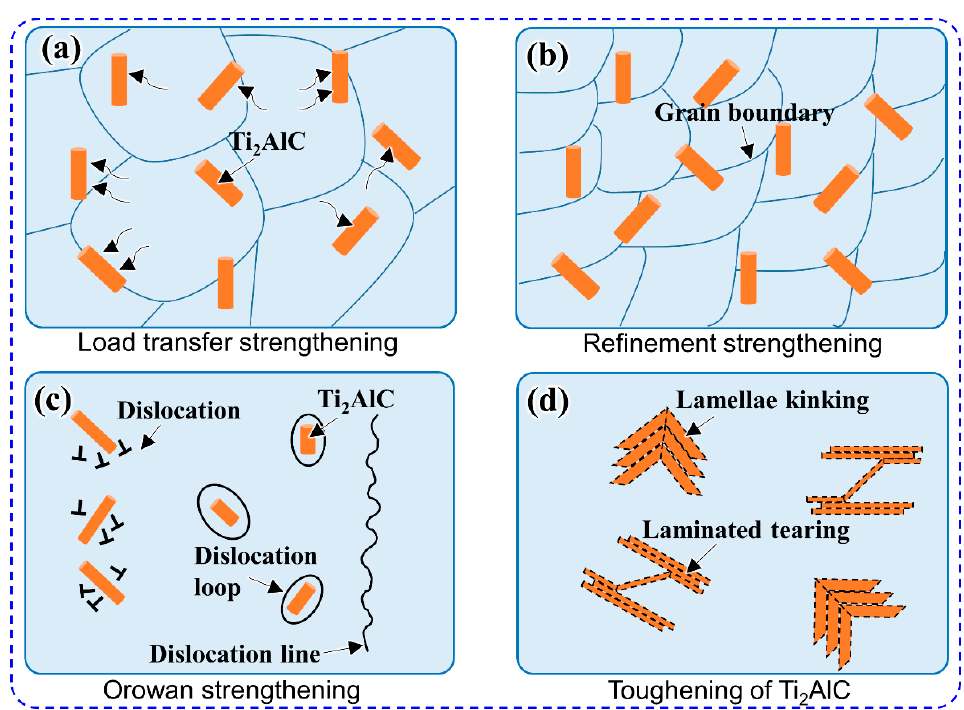
Figure 9. The schematic diagram for the strengthening and toughening mechanism of Ti 2 AlC/TiAl composite: ( a ) load transfer strengthening; ( b ) refinement strengthening; ( c ) Orowan strengthening; ( d ) toughening of Ti 2 AlC.